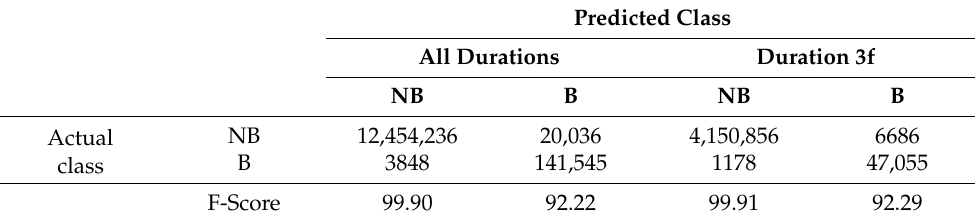
Table 3. Classification